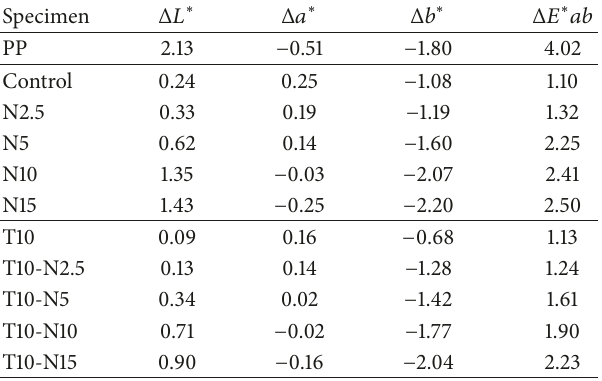
Table 2: Color changes after 1,000 h of weathering in PP, control, NCC-only, NCC-talc hybrid filled PP-based composites.